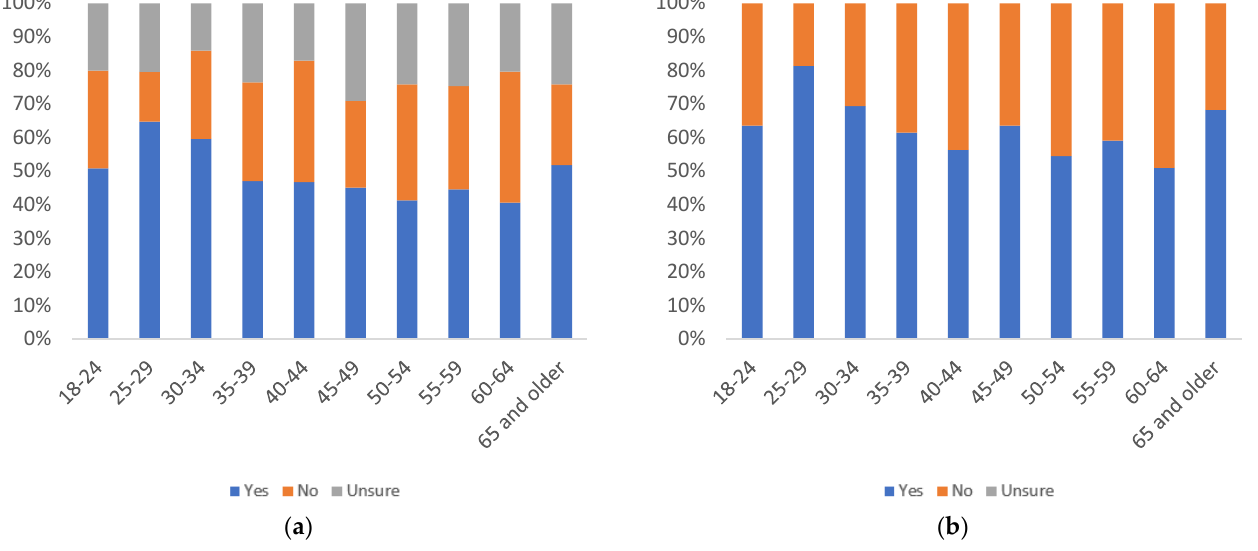
Figure 17. Label trustworthiness judging use, by age group: ( a ) with uncertain respondents (left) and ( b ) without uncertain respondents (right).